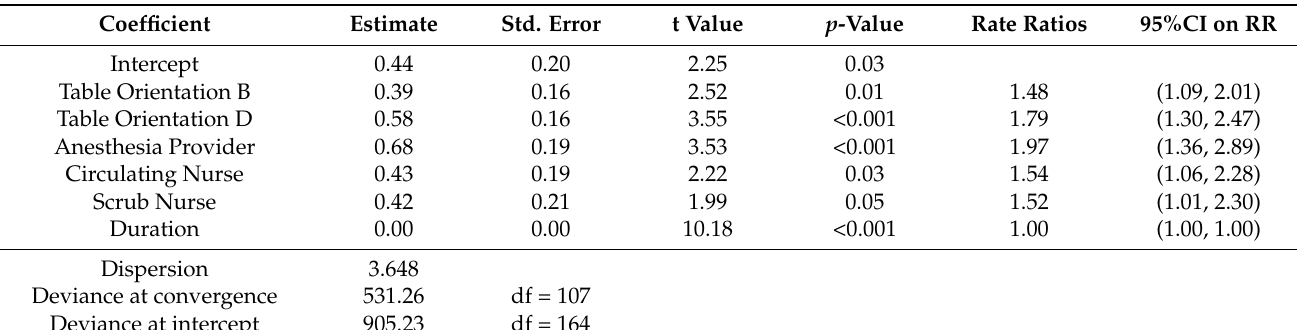
Table 4. Quasi-Poisson regression model predicting the number of major flow disruptions during the intraoperative phase.